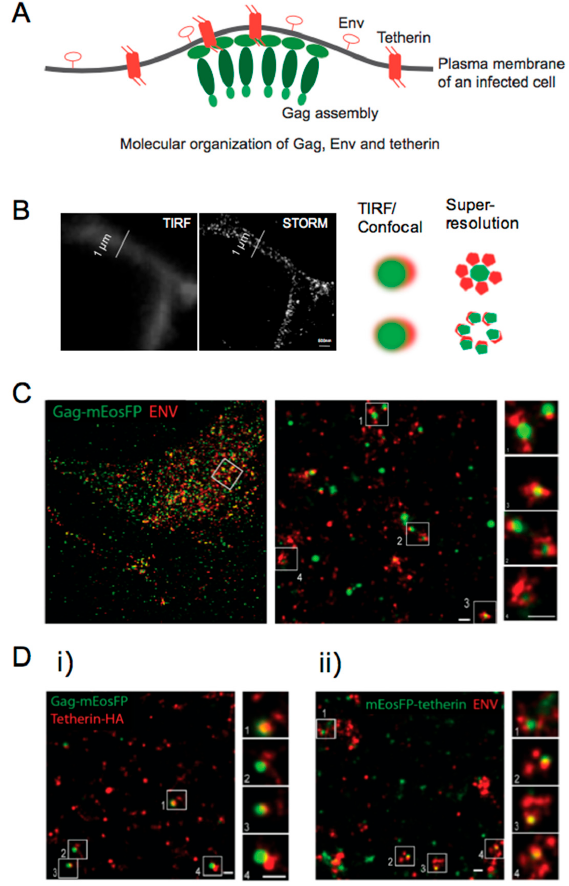
Figure 5. ( A ) Scheme of molecular organization of HIV-1 proteins, Gag and Env and a molecular restriction factor for Gag assembly, i.e., tetherin. A super-resolution microscopy technique was applied which is able to resolve the corresponding structure/organization; ( B ) images of densely distributed fluorescent molecules acquired with TIRFM (diffraction-limited) and super-resolution microscopy techniques. Schemes of “true” and “false” colocalization of molecules detected with diffraction-limited and super-resolution microscopy techniques; ( C ) HeLa cells expressing HIV ∆ Vpu and Gag-mEos (green) were labeled using primary/secondary antibody against gp120 (Alexa Fluor 647, red). The middle and right panels are magnifications of the areas indicated by the white squares in the left and middle panels, respectively; ( D ) representative regions of super-resolution images of HeLa cells transfected with HIV-1 ∆ Vpu and ( i ) Gag-mEosFP and tetherin-HA; ( ii ) Gag-mEosFP and tetherin-Flag. Tetherin-HA and HIV-1 Env were stained by indirect immunofluorescence for HA and Env, respectively. The right panels are magnifications of the areas indicated by the white squares in the left panels. Scale bar of the images is 200 nm. ©Lehmann et al., 2011. Originally published in PLOS PATHOGENS. https://doi.org/10.1371/journal.ppat.1002456 [20].